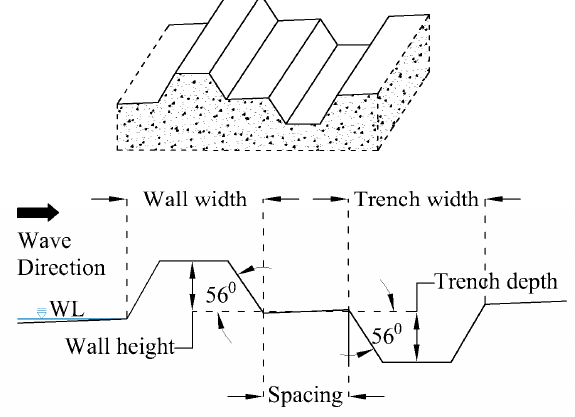
Figure 3. Geometry of the combined wall and trench system that is subjected to testing under Section 3.2. Table 3. Description of simulation cases with the details of onshore structures (in model scale). Case